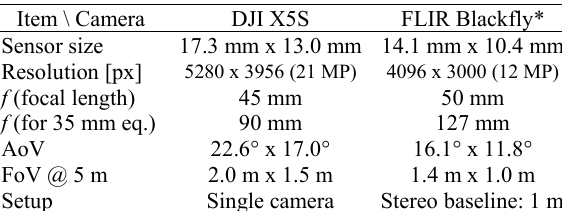
a) Real X5S gimbal. b) Modeled gimbal in Gazebo. Figure 5. Real and modeled X5S gimbal.